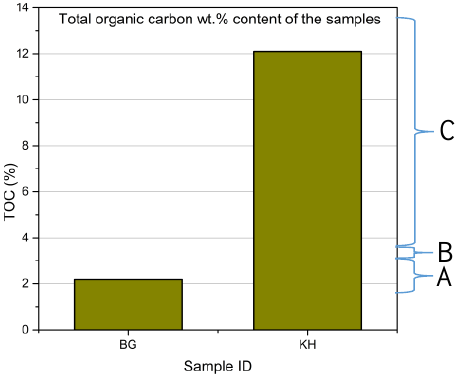
Figure 2. Total organic carbon content for the shale samples.